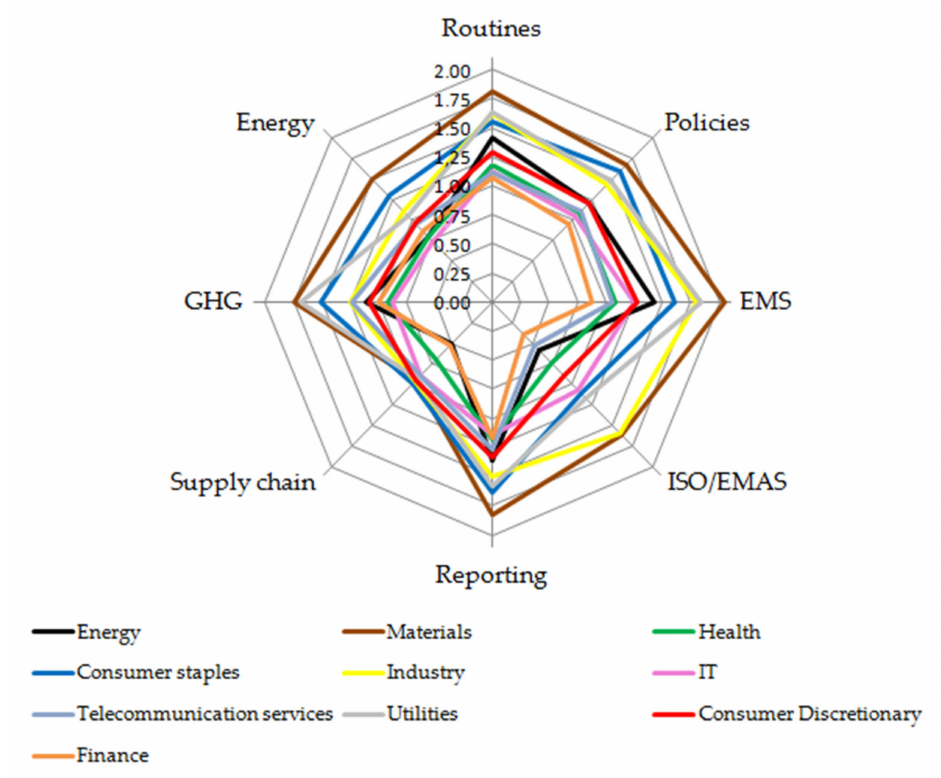
Figure 4. Mean values of grades obtained by sectors in assessed